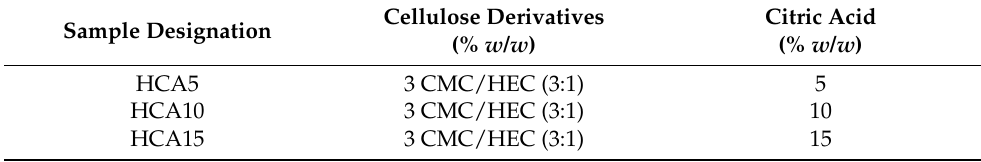
Table 1. Composition of the hydrogel